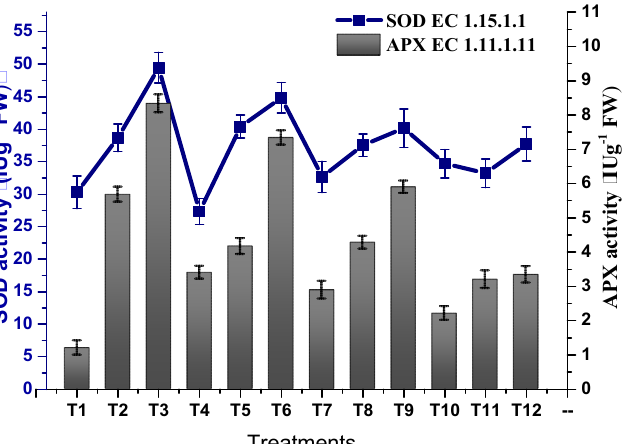
Figure 9. Effect of TU–ANPs on activities of superoxide dismutase (SOD) and ascorbate peroxidase (APX) of Zea mays under various levels of NaCl-based osmotic stress.